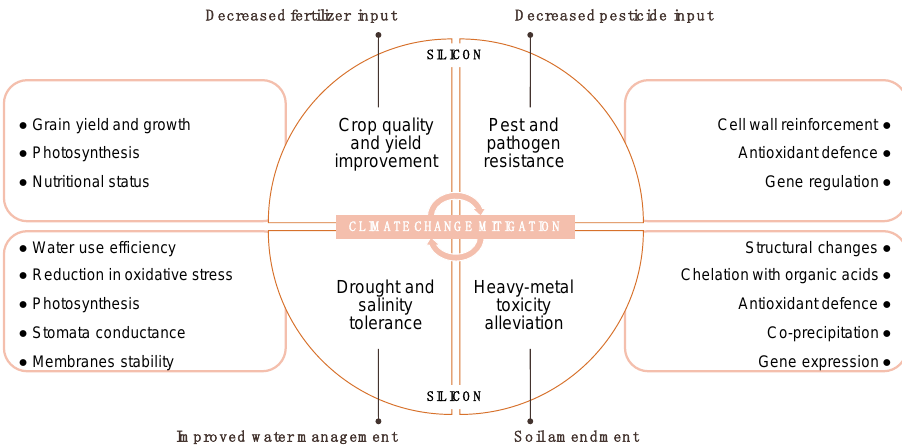
Figure 2. The role of silicon in climate change mitigation and the mechanisms that support sustainable agricultural practices, i.e., decreased fertilizer and pesticide input [151,153 – 168] , improved water management [35,169 – 178] , and soil amendment [130,157,161,179 – 190] .